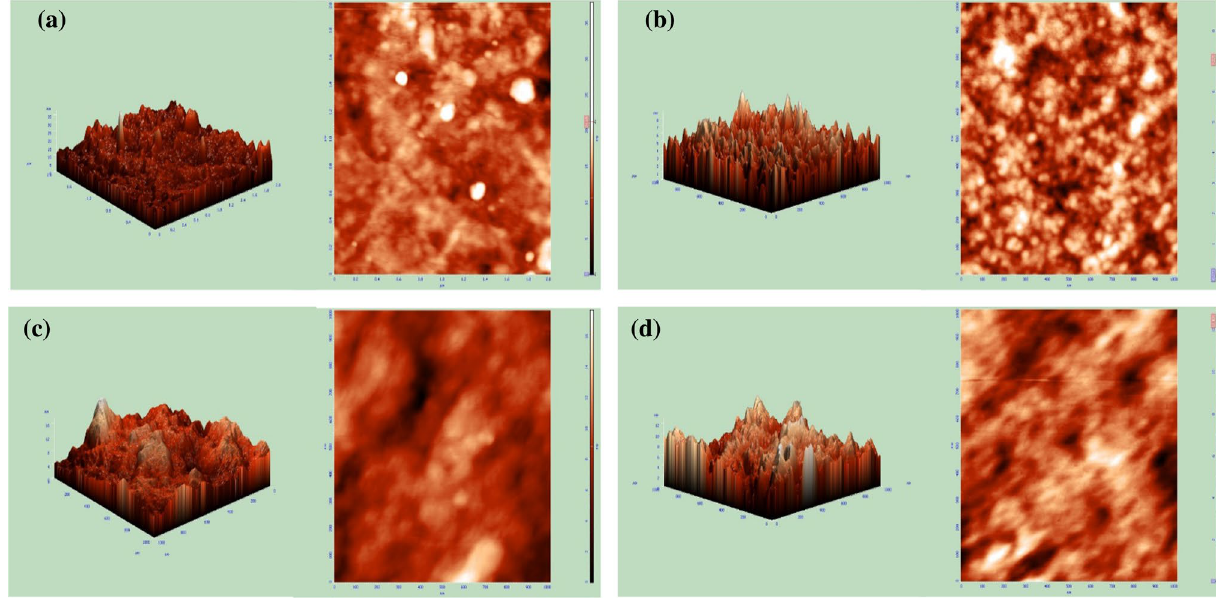
Fig. 5 AFM surface roughness images for the a PVA, b PVA/MA, c PVA/TA, and d PVA/LA films